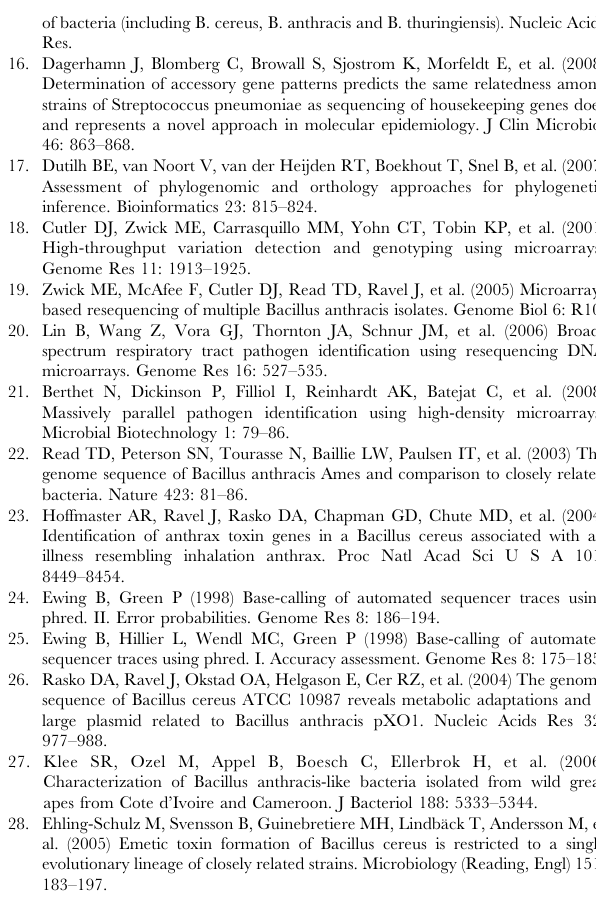
Figure S1 Phylogenetic tree inferred for 36-strains with MLST data. Neighbor-joining phylogenetic tree inferred using multilocus sequence typing (MLST) data for a subsample of 36 B. cereus strains. Bootstrap values for nodes with greater than 99% support (1000 replicates total) are shown. Figure S2 Phylogenetic tree inferred for 36-strains with RA data. Neighbor-joining phylogenetic tree inferred using resequen- cing array (RA) data with a quality score threshold of 30 for a subsample of 36 B. cereus strains. Bootstrap values for nodes with greater than 99% support (1000 replicates total) are shown. The purple box marks a clade of Bacillus strains with low basecalling rates. This clade is not observed in comparable MLST phylogenetic tree (Figure S1). We infer that the low RA basecalling rates for these strains resulted in their clustering together in a false clade. Table S1 B. anthracis strains resequenced in Zwick, M. E. et al. (2005) Found at: doi:10.1371/journal.pone.0002513.s003 (0.06 MB PDF) Table S2 BDRD-01 resequencing array (RA) reference se- quence information.